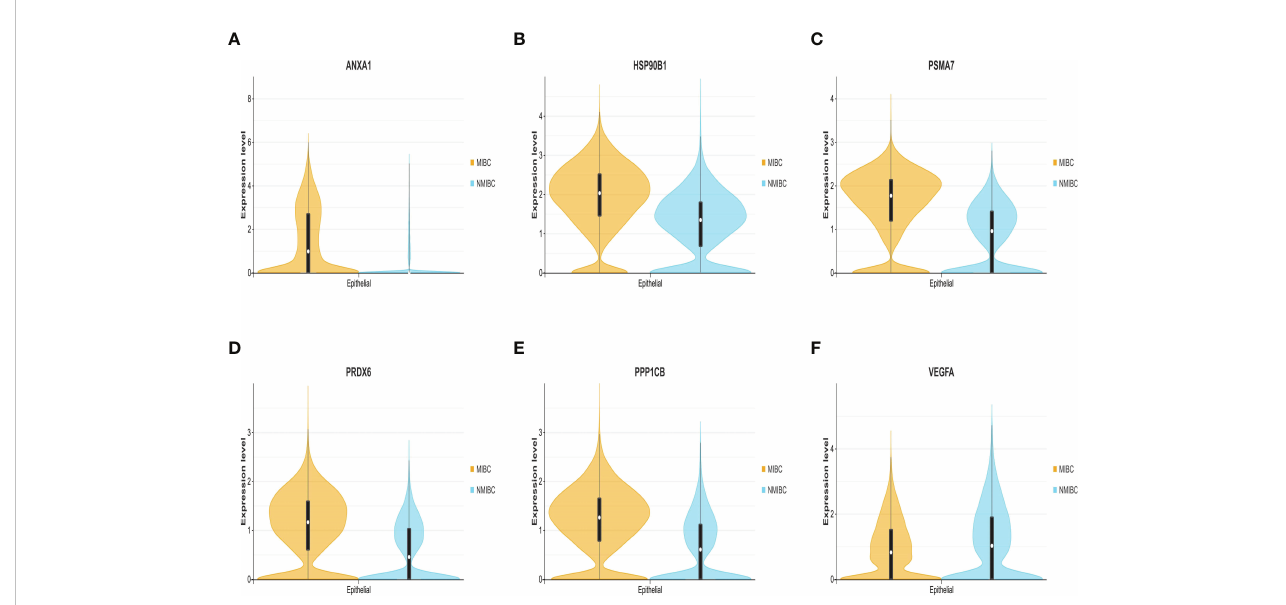
FIGURE 6 (A – F) The expression level and density of ANXA1, HSP90B1, PSMA7, PRDX6, PPP1CB, and VEGFA genes between MIBC and NMIBC in epithelial cluster. MIBC, muscle-invasive bladder cancer; NMIBC, non-muscle-invasive bladder cancer.